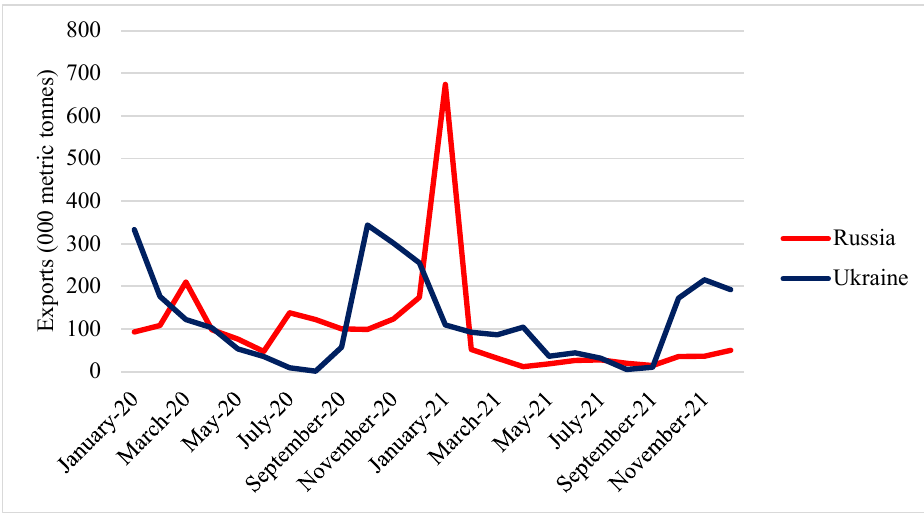
Our next effort was to consider the role of Russia and Ukraine as soybean exporters. Russia and Ukraine are exporters of soybeans to the world market, although in small quantities (Figure 9). Both countries’ export trends indicated a slight rise by a certain amount. The peak of Ukrainian soybean exports occurred in October, while Russian soy- Figure 8. Turkey’s ( a ), Egypt’s ( b ), and Bangladesh’s ( c ) wheat import structure. Source: [30]. bean exports fluctuated dramatically.